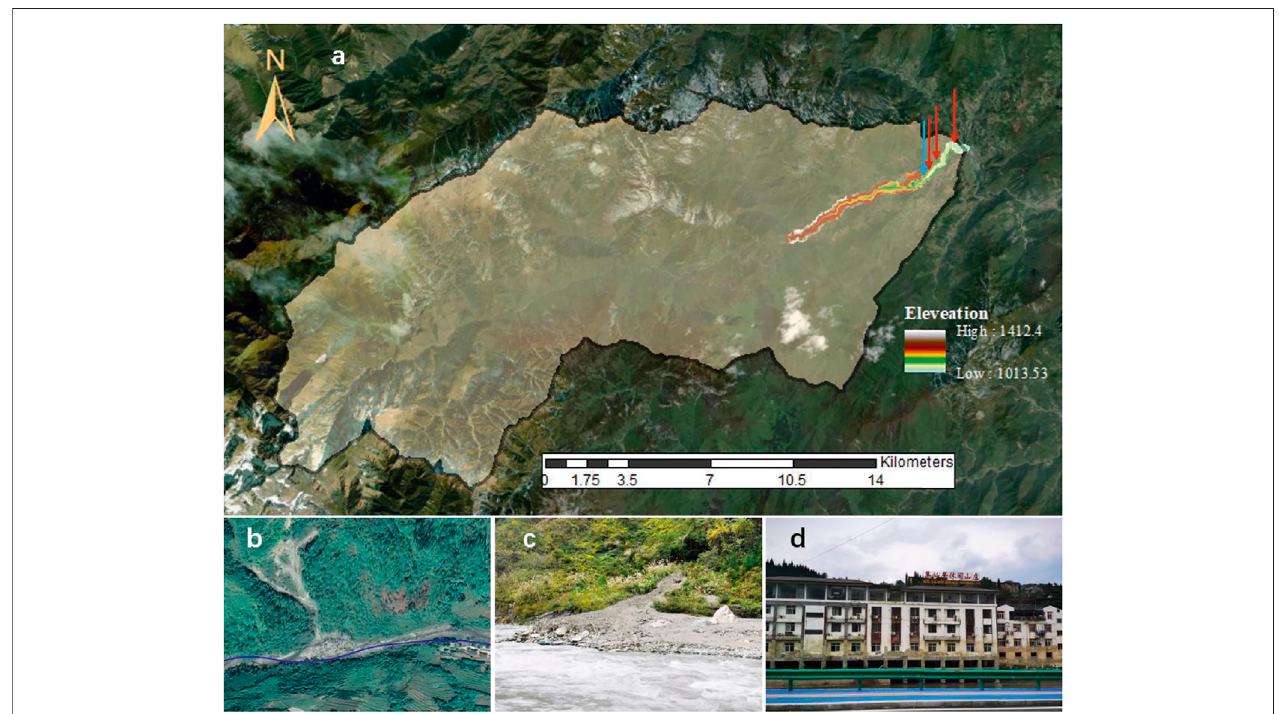
FIGURE1| Overviewoftargetwatershedandsimulatedreach. (A) Satelliteimage oftheXihewatershedandthesimulatedreach.Backgroundimageoftheterrain from © Google Earth. (B) Satellite image and (C) photo of debris in fl ow at Chainage 5,700 m. (D) Photo of fl ood mark of the residents at Chainage 9,500 m. Blue arrow indicated Chainage 5,700 m, where came the debris fl ow. Red arrows indicated Chainage 6,100, 7,100, and 9,500 m, which located near the residence.